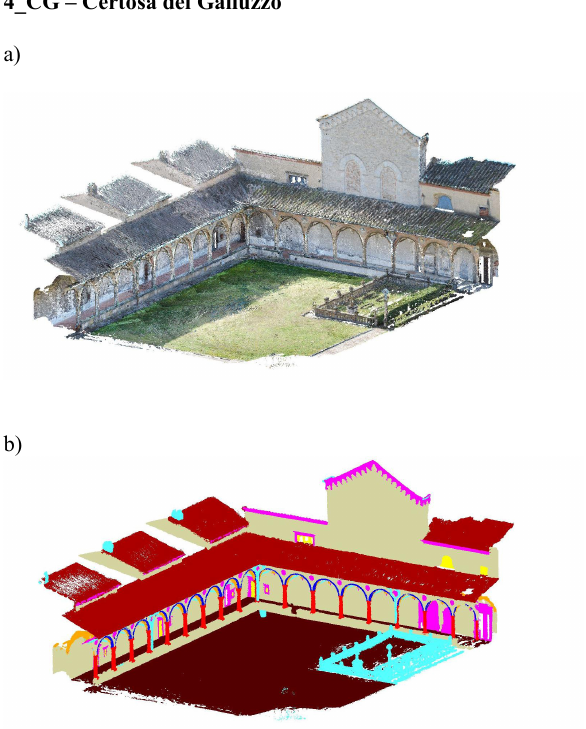
Figure 8 . a) RGB photogrammetry point cloud and b) corresponding labelled cloud of Certosa del Galluzzo.